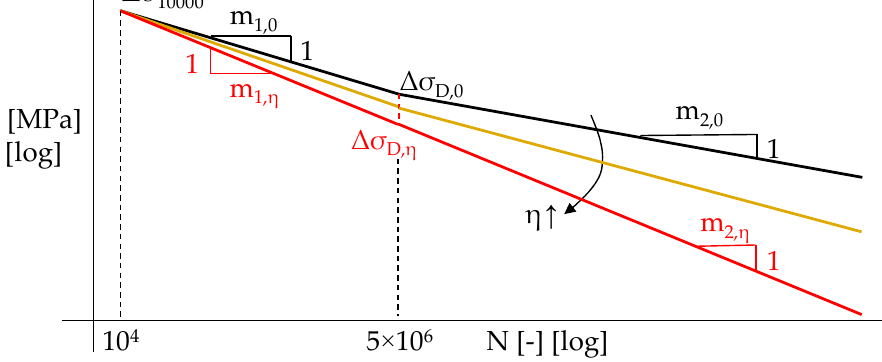
Figure 5. Assumed shape of S-M- η domains for corrosion fatigue analyses.